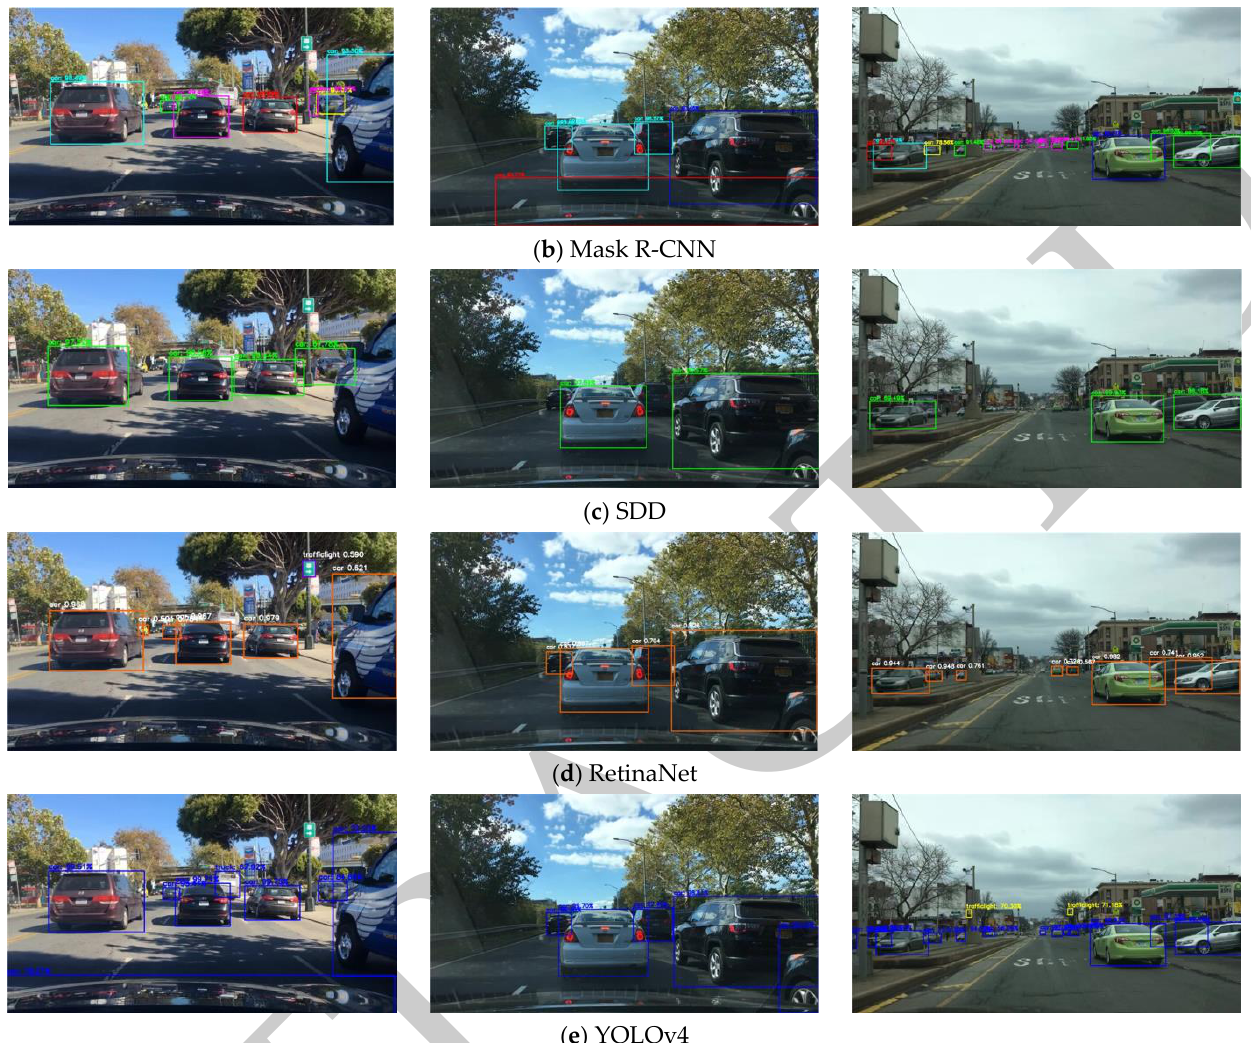
Figure 13. Performance of five deep learning models in different road environmental conditions (from left to right columns: clear, partly cloudy, and overcast).